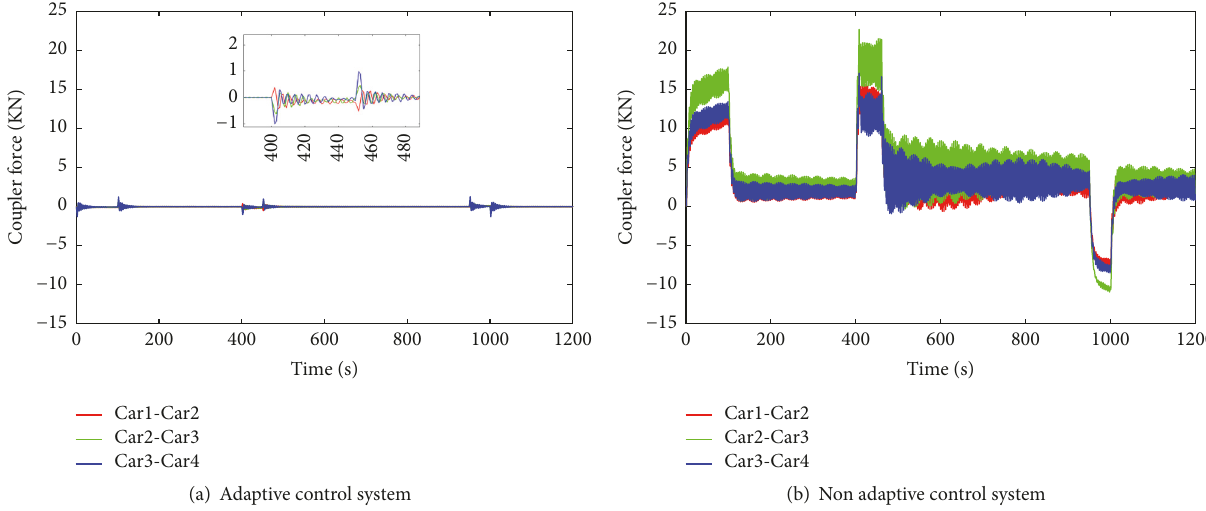
Figure 10: Comparison of adaptive control system with nonadaptive control system in predicted output velocity and the desired velocity error.